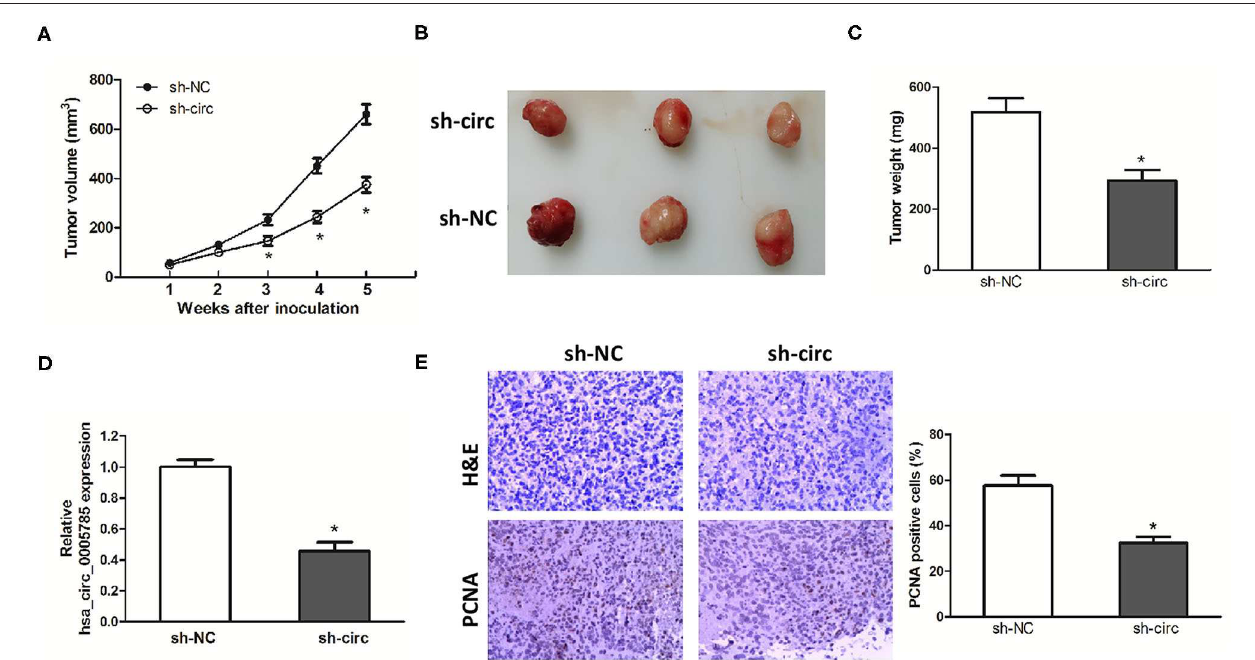
FIGURE 4 | hsa_circ_0005785 knockdown suppresses tumor growth in vivo . (A) Tumor growth curves measured after injection of SK-HEP-1 cells treated with sh-NC and sh-circ. (B) Xenograft tumors were photographed after 5 weeks of inoculation. (C) Tumor weight in sh-NC- and sh-circ-treated groups after dissection of the tumor body. (D) qRT-PCR detection of hsa_circ_0005785 expression in the resected tumor tissues. (E) H&E staining and immunohistochemical staining against the PCNA antibody in sh-NC- and sh-circ-treated groups ( × 200), * P <